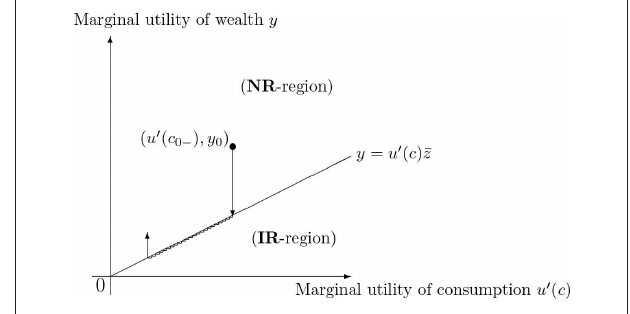
FIGURE 1 | NR and IR regions and consumption